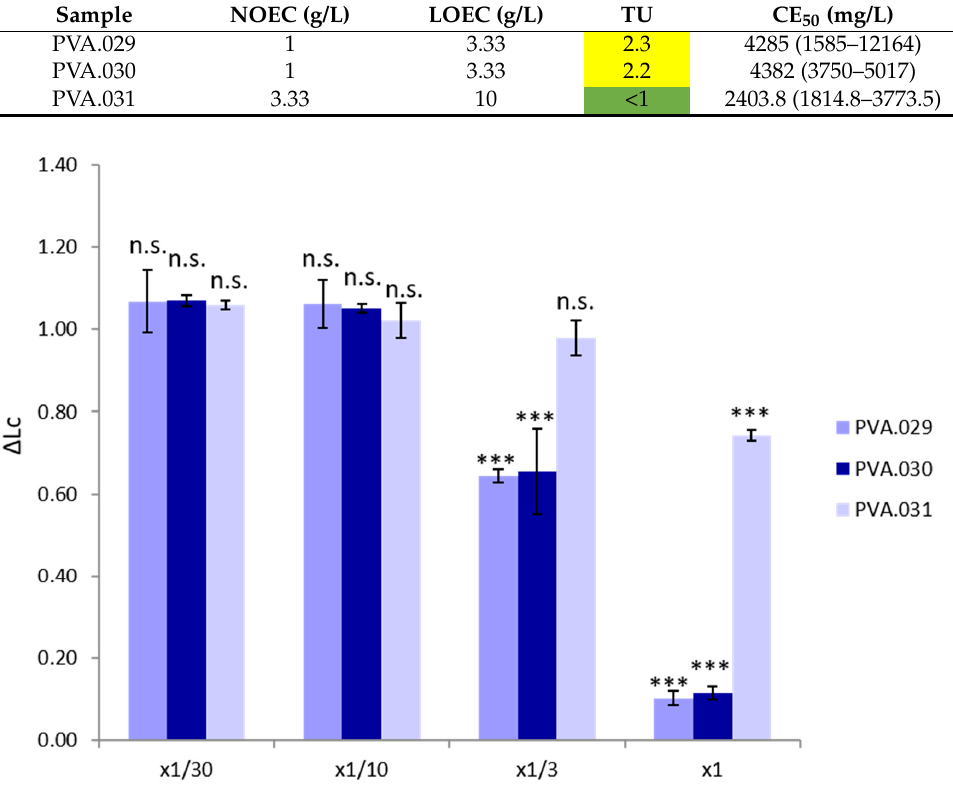
Figure 2. Paracentrotus lividus larvae size increase ratio compared to control treatment ( ∆ Lc) for the different sample dilutions. * p < 0.05, ** p < 0.01, *** p < 0.001.